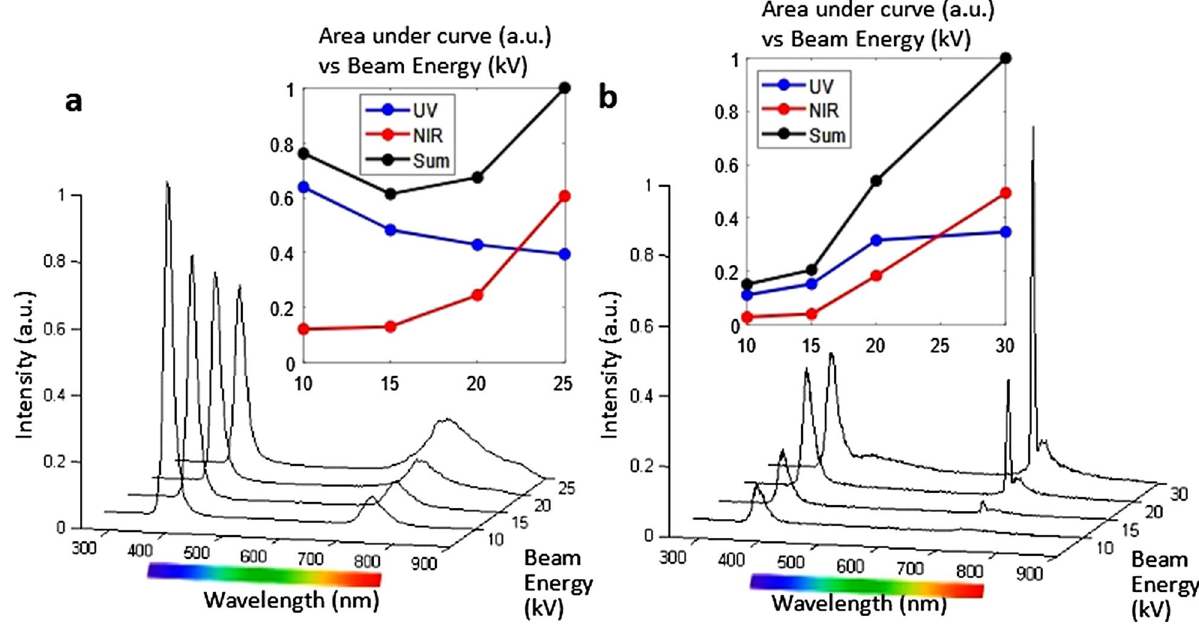
Figure 2. CL spectra for w-GaN NwN vs applied electron beam energy at ( a ) room Temperature (300 K) and ( b ) cryogenic temperature (≈ 93 K). Insets show the area under the curve of UV and NIR